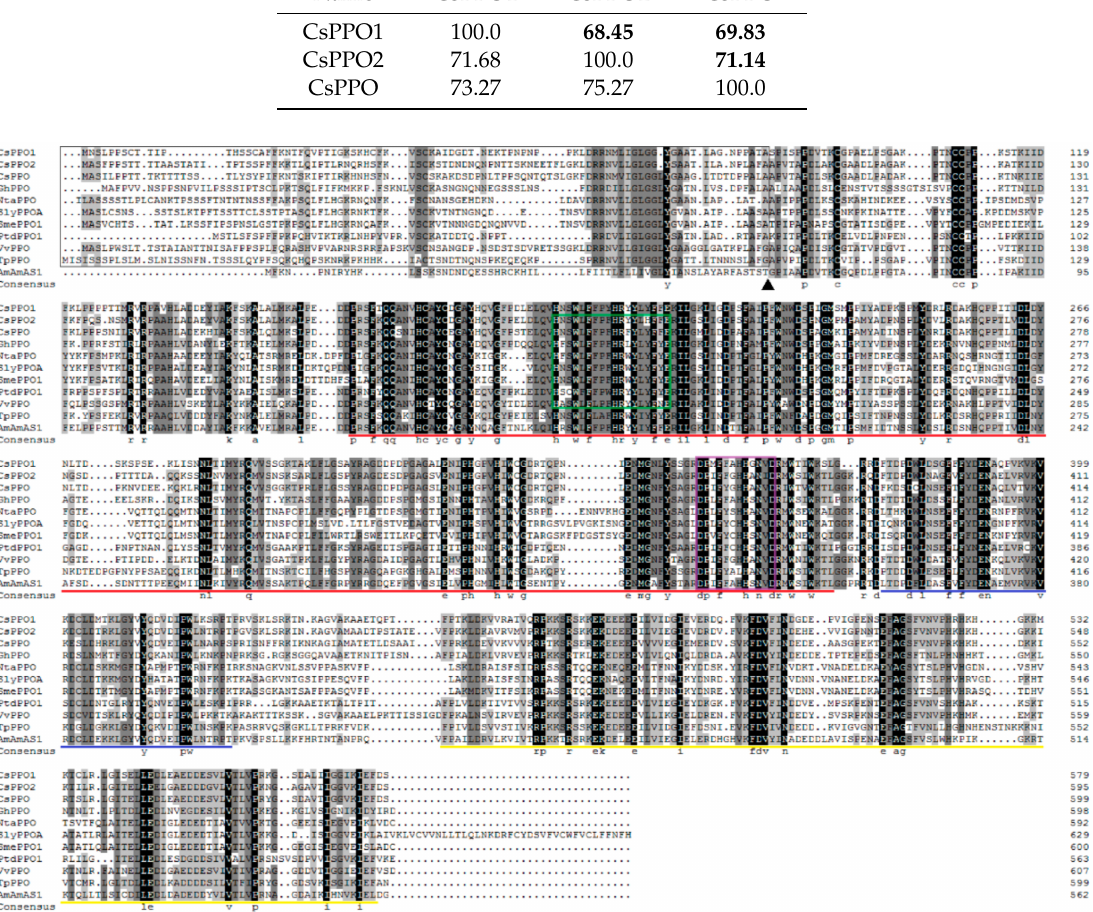
Figure 1. Amino acid sequence alignment of three polyphenol oxidases (PPOs) in C. sinensis and other plant PPOs. The region corresponding to the chloroplast transit peptide is boxed, and the thylakoid peptidase-processing site is indicated by (cid:78) . The three domains: red underline, tyrosinase domain; blue underline, PPO1_DWL domain; yellow underline, PPO1_KFDV domain. The green box refers to the CuA binding site; the purple box to the CuB binding